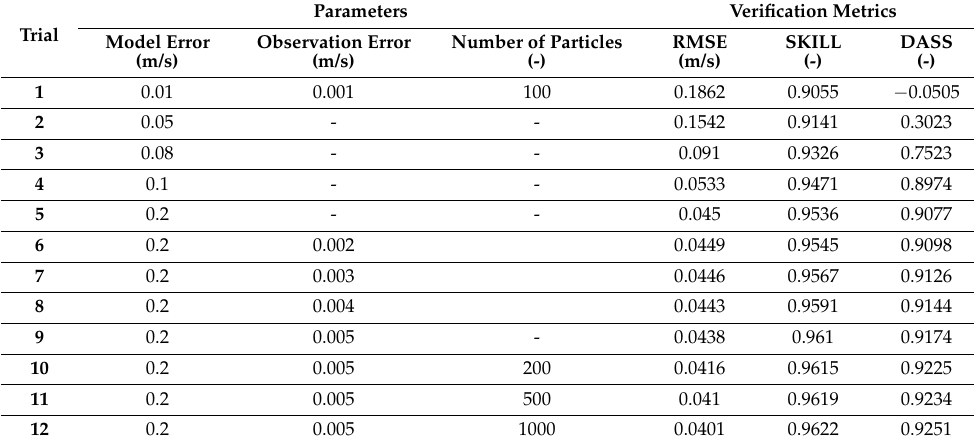
Table 3. The sensitivity parameter settings of the particle filter.